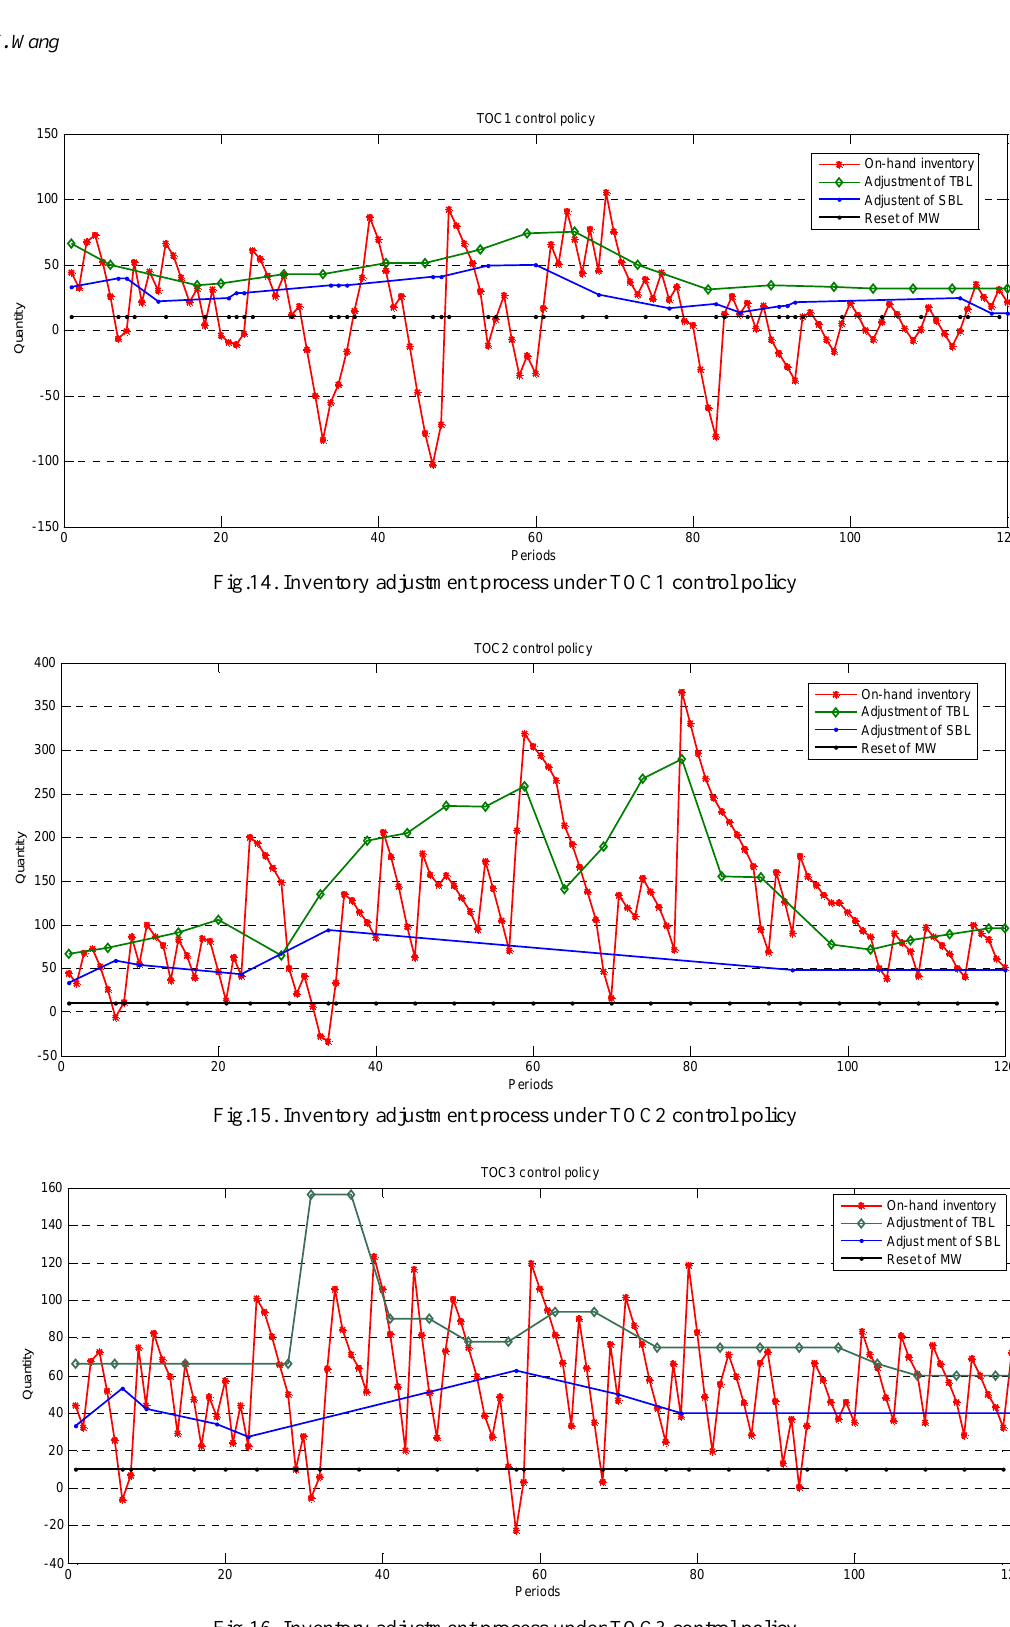
Fig.16. Inventory adjustment process under TOC3 control